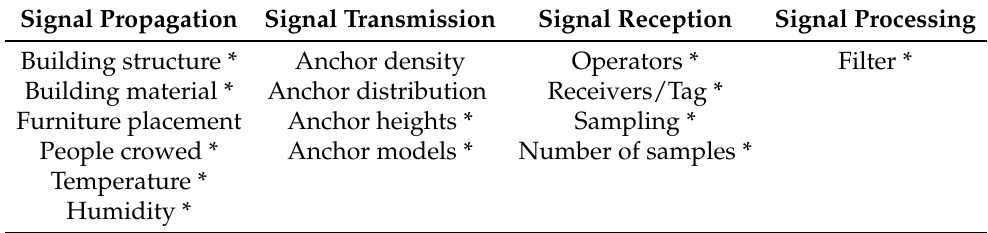
Table 2. Impact factors on indoor positioning systems (factors indicated by * are fixed in the experi- ment